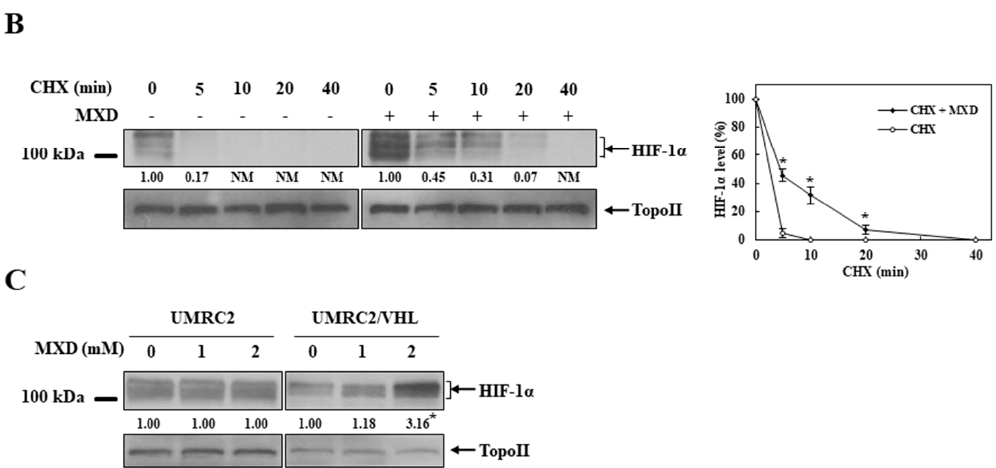
Figure 3. Millimolar minoxidil stabilizes HIF-1 α protein. ( A ) HaCaT cells ( Left ) or DPCs ( Right ) were treated with diazoxide (2 mM) or minoxidil (MXD, 2 mM), which are potassium channel activators. HIF-1 α in the nuclear extracts was analyzed by Western blot ( n = 5). * p < 0.05 versus untreated group. TBP: TATA binding protein; ( B ) HaCaT cells were either left untreated or were pretreated with MXD (2 mM) for 4 h, followed by an addition of cycloheximide (CHX, 200 µ M) for the indicated times. HIF-1 α in the nuclear extracts was analyzed by Western blot. The data in the graph represent mean ± SEM ( n = 5), * p < 0.05 versus group treated with CHX alone or initial HIF-1 α level. Topo II: Topoisomerase II; ( C ) Renal carcinoma cells that are deficient for von Hippel–Lindau protein (VHL) function (UMRC2) or a clonally selected line with VHL stably expressed (UMRC2/VHL) were treated with MXD for 4 h. HIF-1 α in the nuclear extracts was analyzed by Western blot ( n = 5). * p < 0.05 versus untreated group. Western blot results are representative of five independent experiments. Topo II: Topoisomerase II.